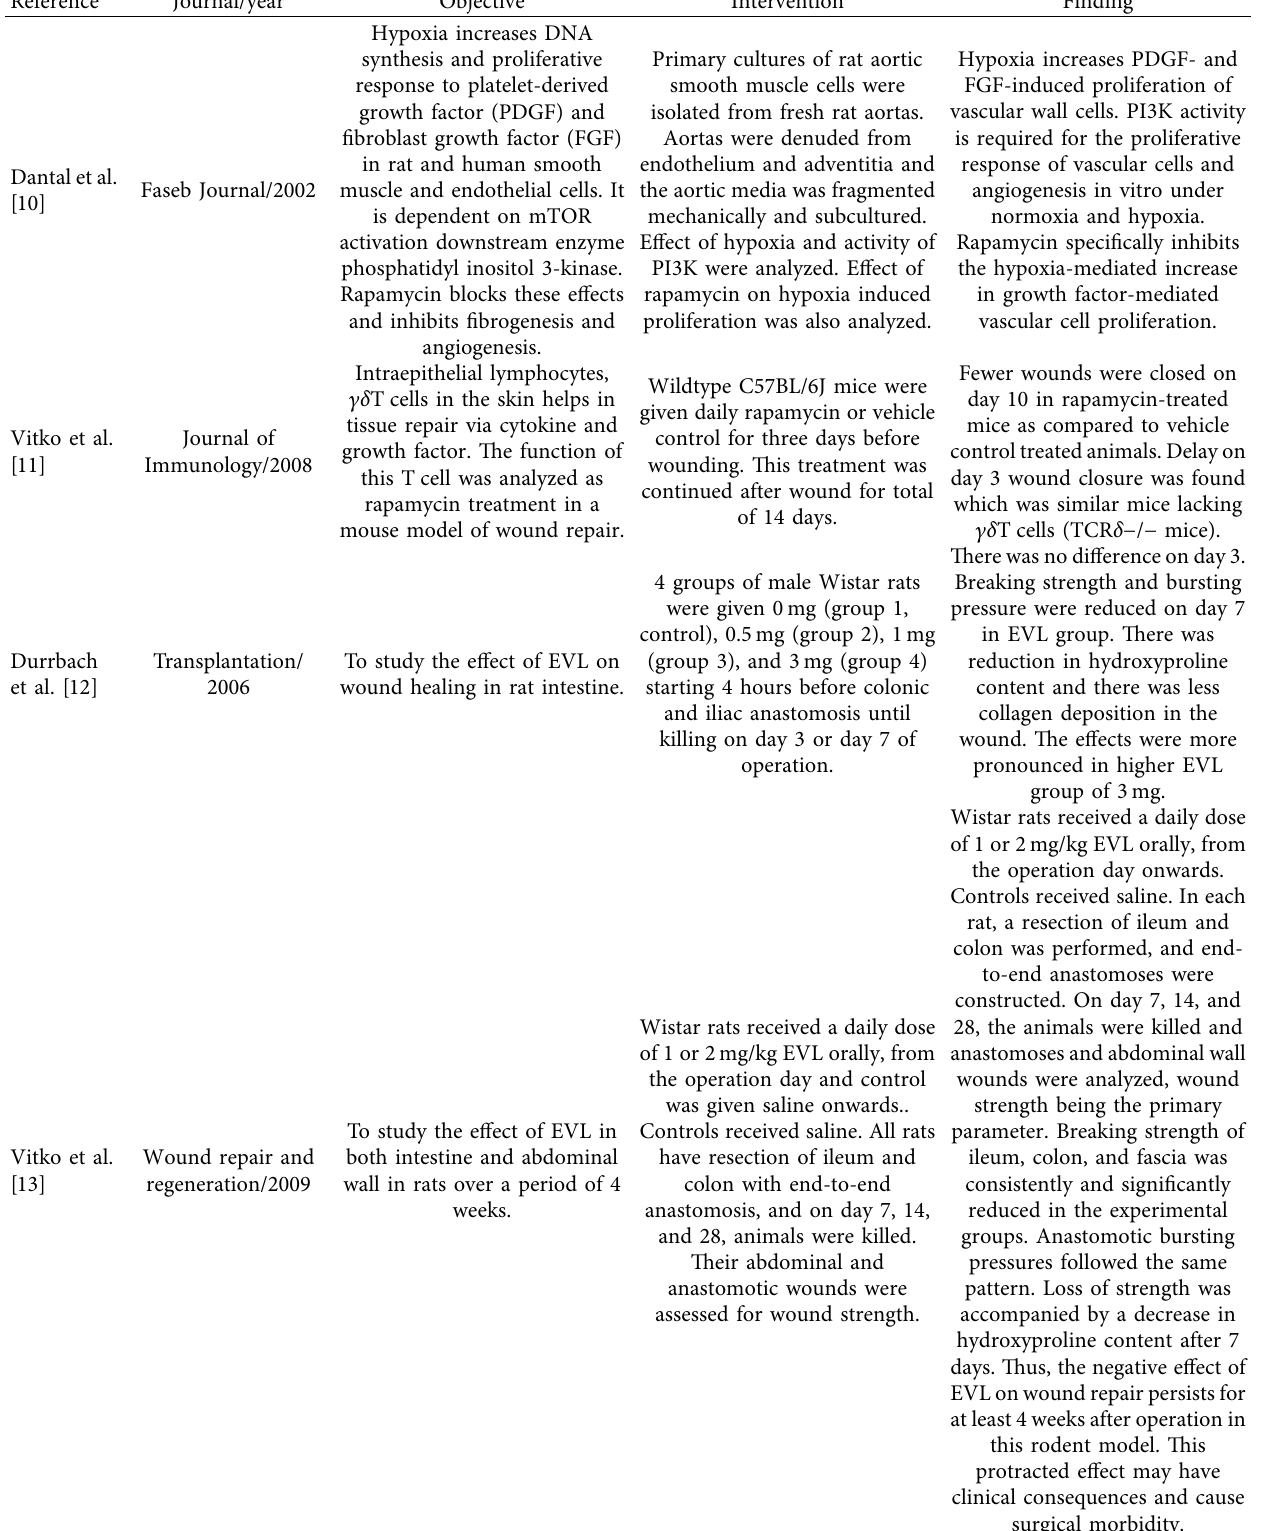
Table 1: Animal studies on mTOR-I to study its impact on wound